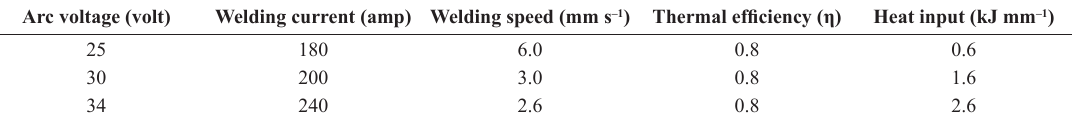
Table 2. Welding